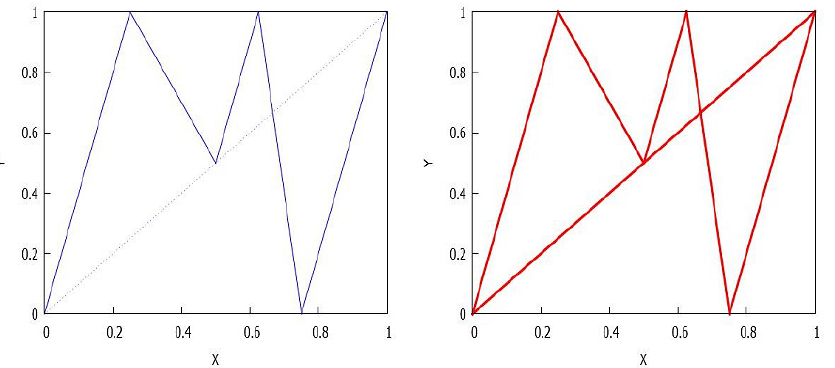
Figure 32. The map ϕ 3 and the ω -limit set ω Φ